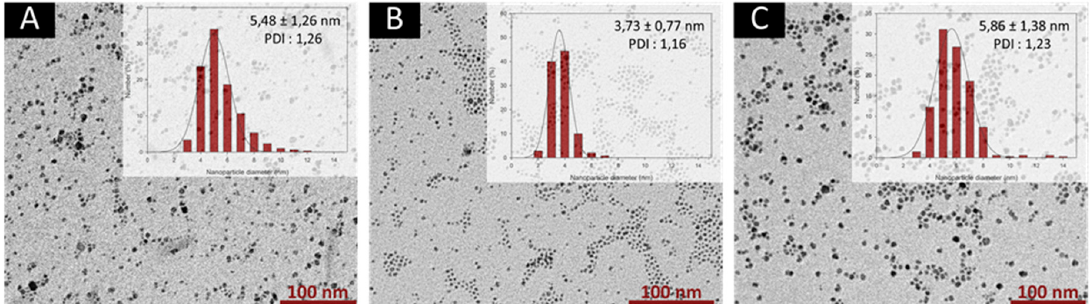
Figure 4. TEM images of the nanoparticles obtained through flow synthesis with various equivalents of oleic acid and oleylamine: Two equivalents ( A ), four equivalents ( B ) and six equivalents ( C ) in the 1 mm capillary reactor. The scale bar corresponds to 100 nm. Insets show the size distributions determined by statistical analysis.